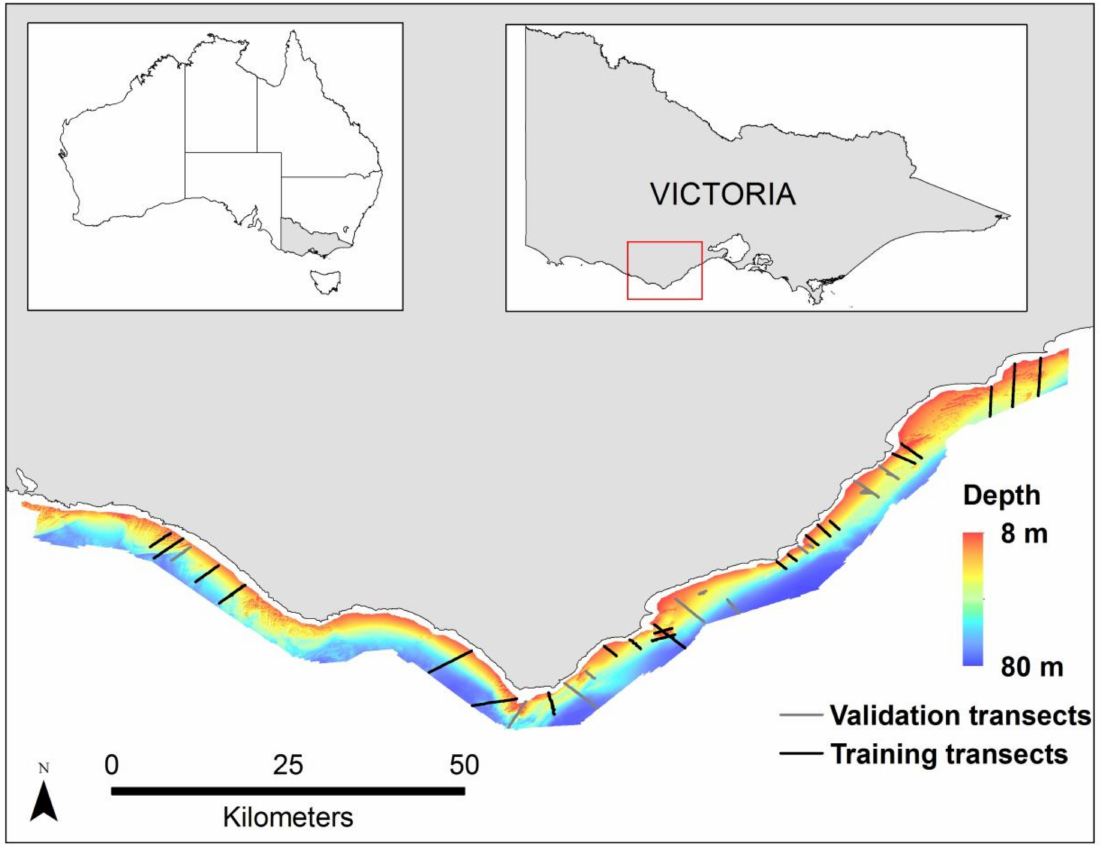
Figure 1. Location of Cape Otway in Victoria, Australia, and the multibeam echosounder (MBES) bathymetry overlaid on a bathymetric hillshade of the study site. The western side of the cape is exposed to prevailing south-westerly ocean swells, while the eastern side is moderately protected by comparison. Black lines represent the transects selected for training and the gray lines represent transects selected for